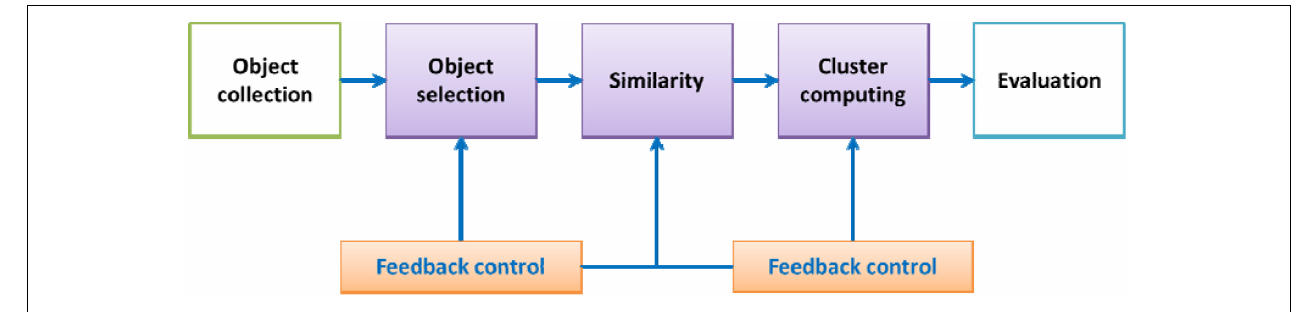
FIGURE 2 | Cluster analysis flowchart.